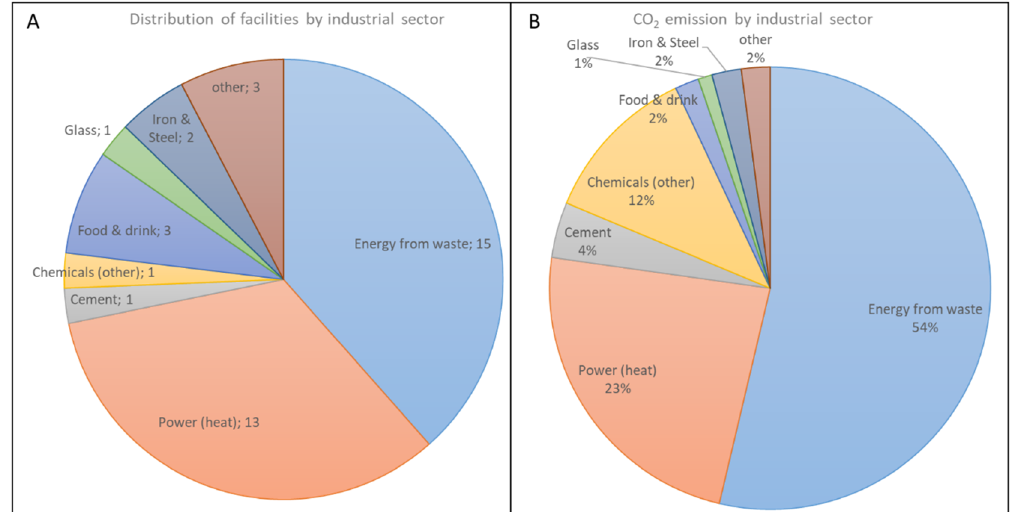
Figure 6. ( A ) Number of facilities by industrial sector and ( B ) the respective percentage of these sectors in the global amount of CO 2 emission of the region in 2019.